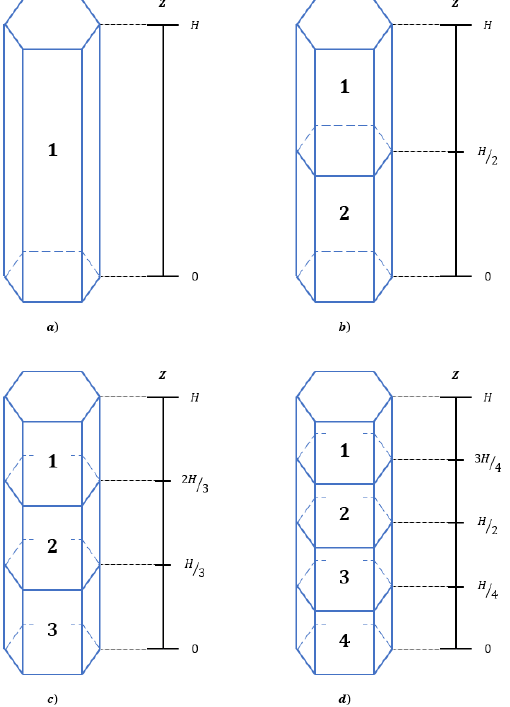
Figure 8. Axial ( a ) × 1, ( b ) × 2, ( c ) × 3, and ( d ) × 4 refinements made in the AZNHEX